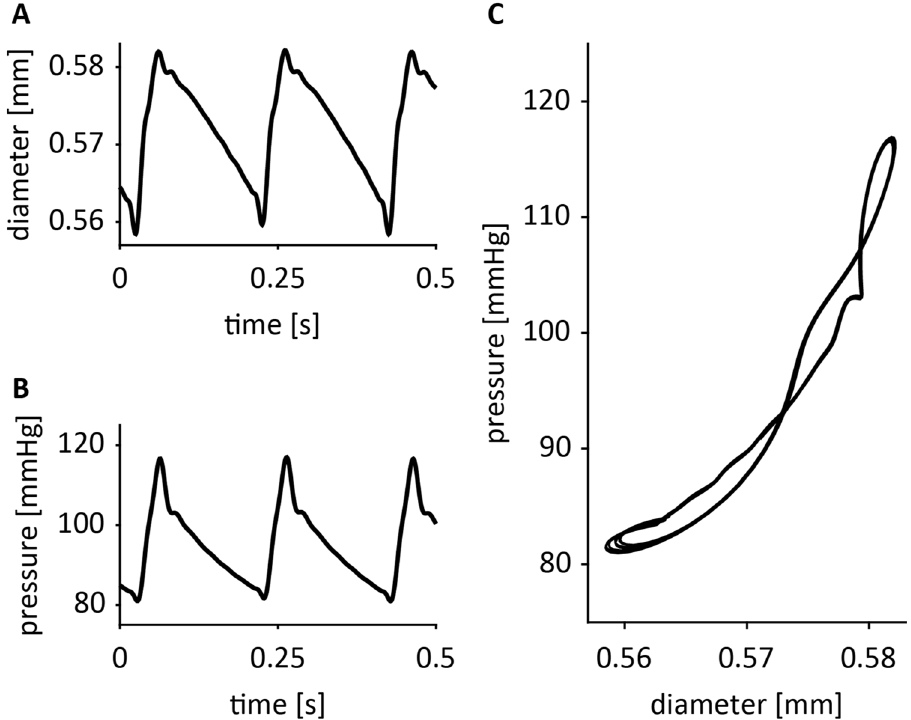
Figure 3. Representative examples of inner diameter ( A ) and pressure ( B ) tracings, and the resulting pressure- diameter plot ( C ), exposing considerable curvilinearity but rather limited loop